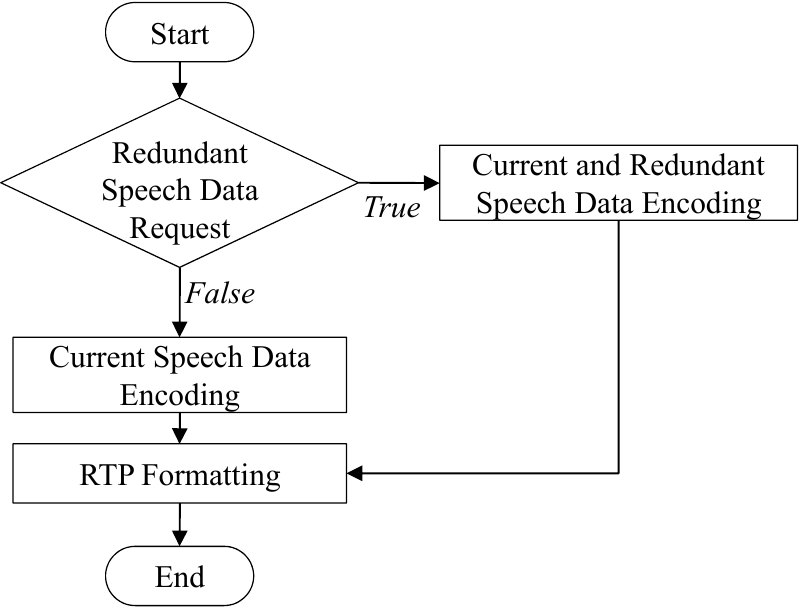
Figure 7. Procedure of transmitting the scalable speech coding bitstream and the adaptive RSD transmission at the sender